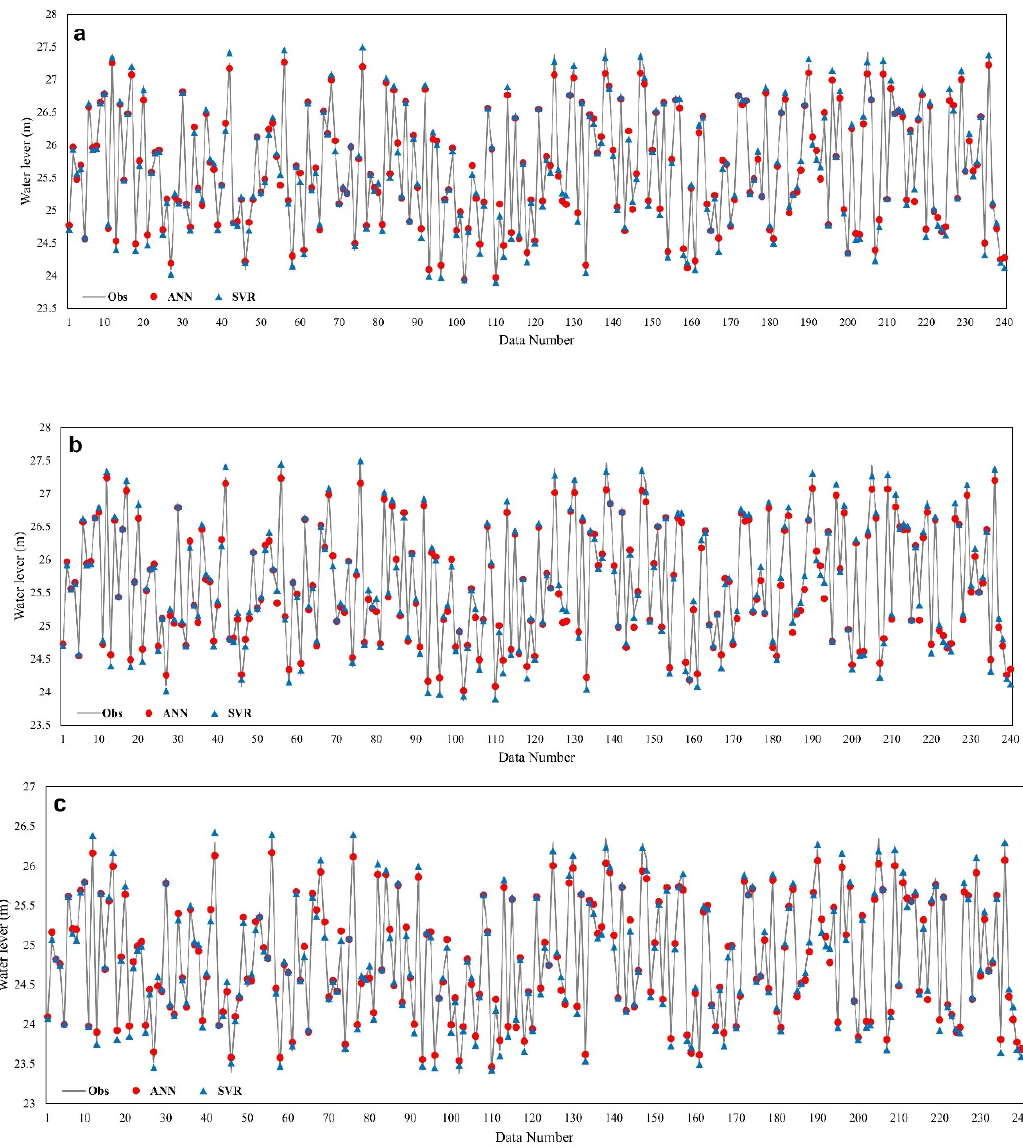
Figure 6. Comparison of observed and predicted water level for test set by ANN and SVR at cross section 1 ( a ), cross section 2 ( b ), and cross section 3 ( c ). Table 2. Initial emulator performance (developed using 14 inputs) on test